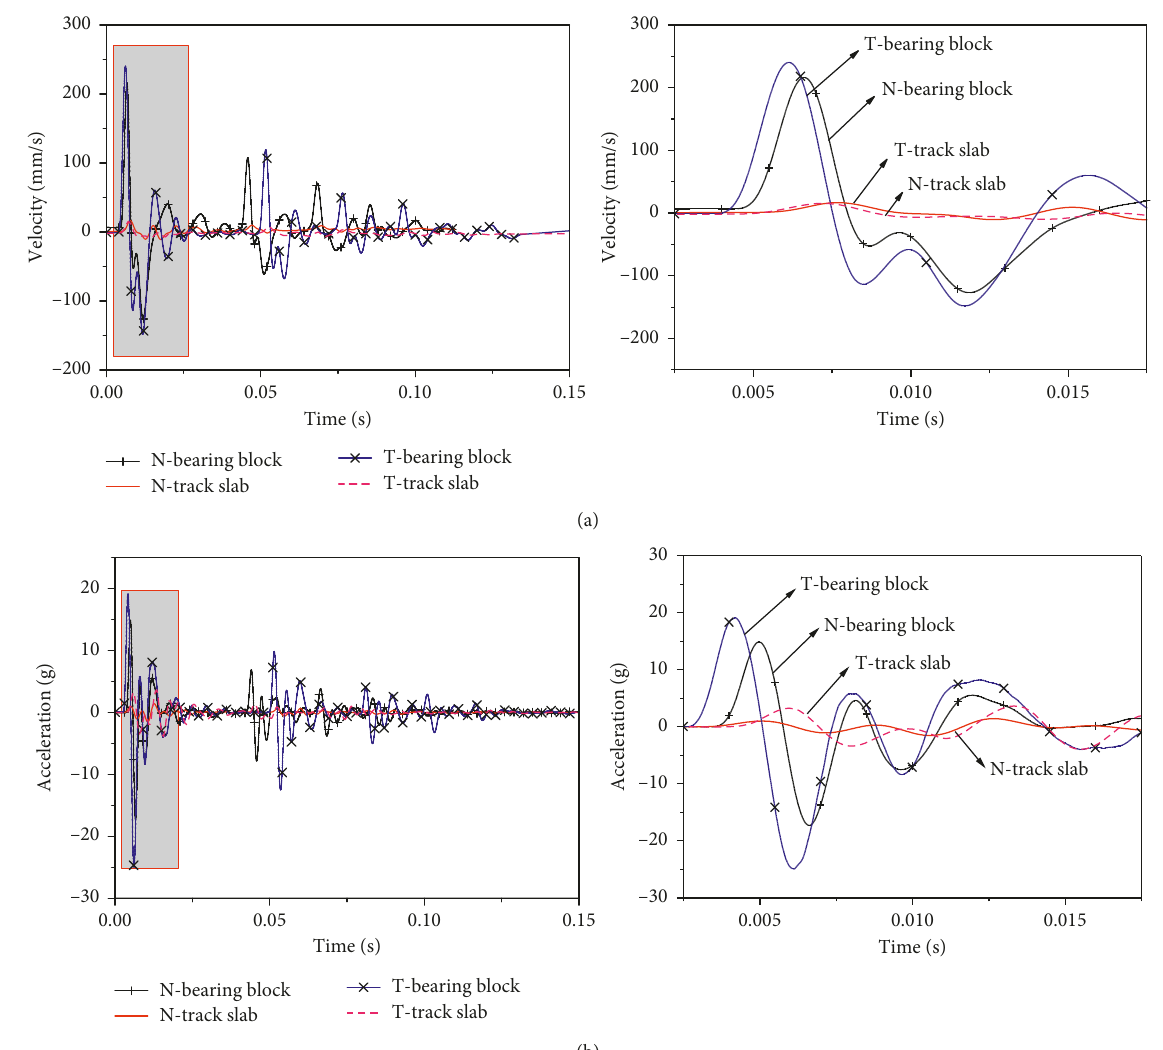
Figure 10: Velocity and acceleration time-history curves at the fastener No. 6. (a) Velocity: (left) full chart; (right) enlarged details. (b) Acceleration: (left) full chart; (right) enlarged